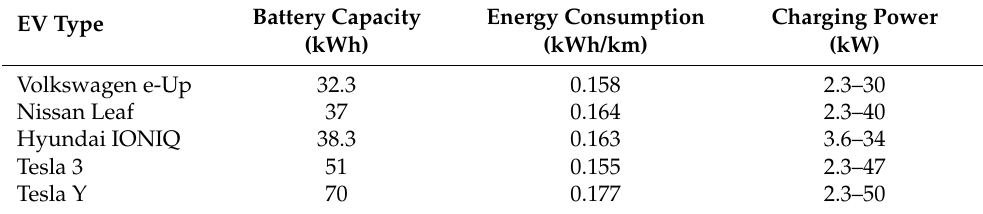
Table 1. EV Types and Specifications.